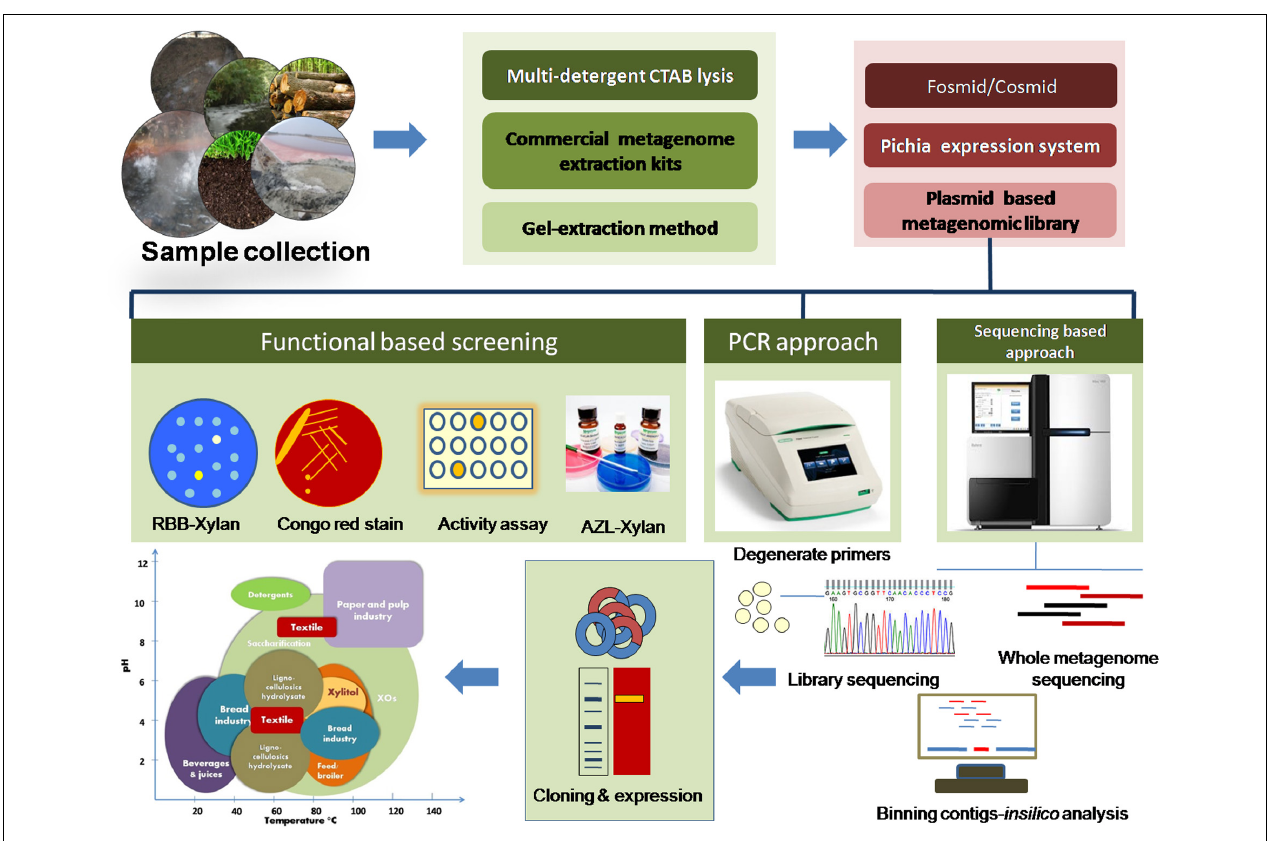
FIGURE 1 | Schematic representation for retrieving xylan-degrading enzymes using metagenomic